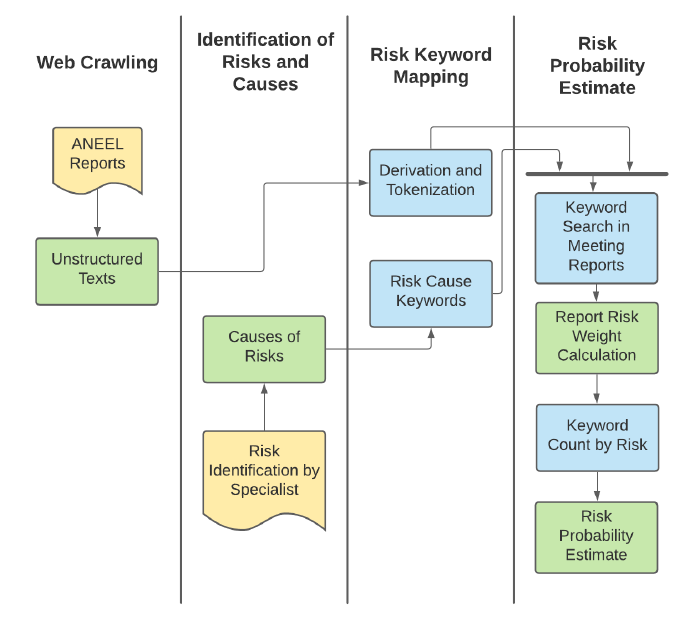
Figure 1. Diagram representing the methodology steps. First, the weekly reports are extracted from ANEEL’s website through web crawling. Secondly, the risks and causes are listed by an expert. Then, the unstructured reports are processed using NLP techniques, and keywords are extracted from the risks’ causes. Finally, the risk probability is